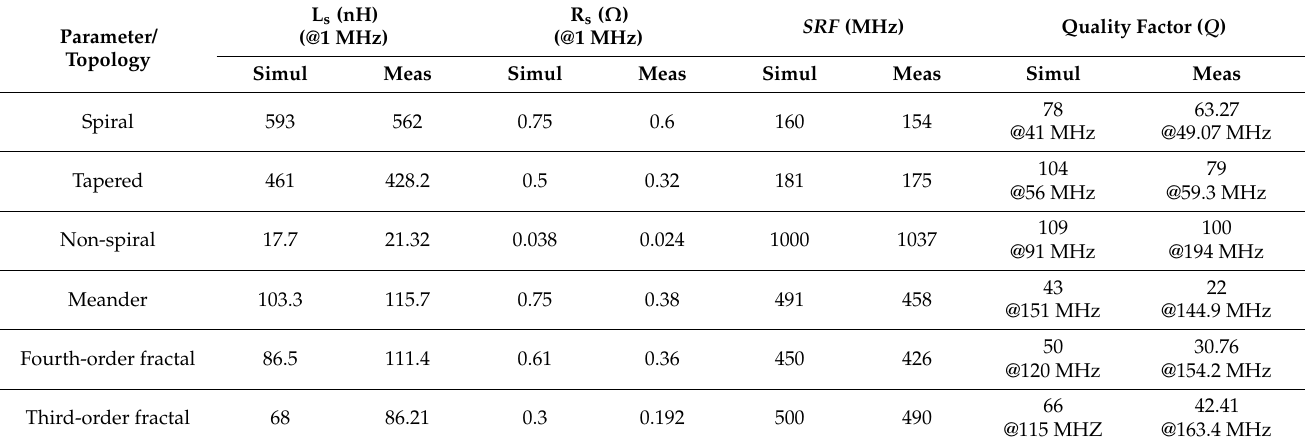
Table 2. Measured/simulated initial electrical parameter values of different inductor topologies